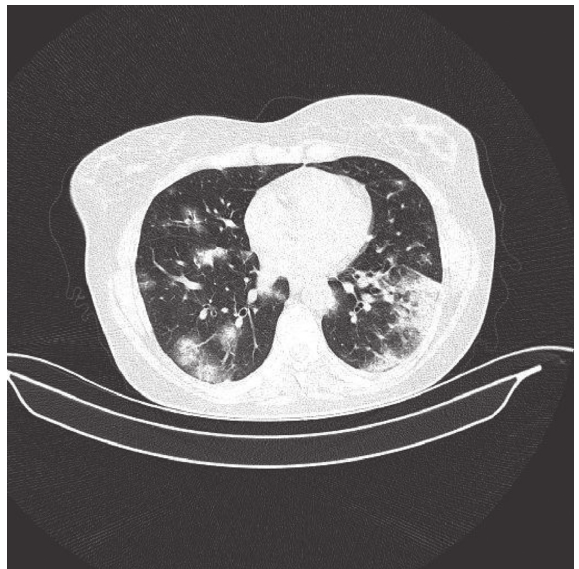
Figure 1: Axial CT image shows bronchocentric and nodular organizing pneumonia patterns and ground-glass opacifications.